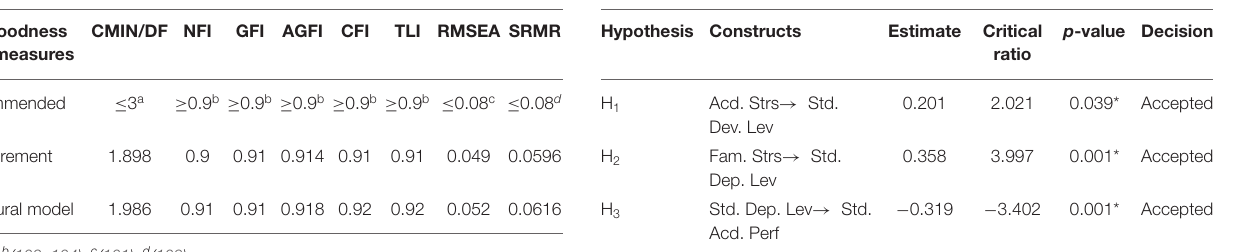
TABLE 4 | Analysis of measurement and structural